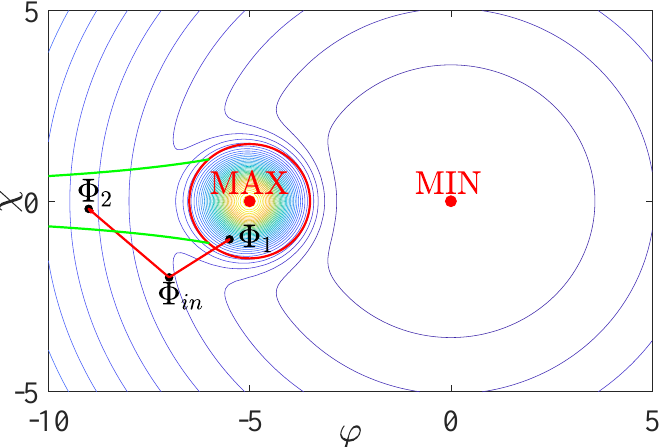
Figure 4. The contour plot of the potential (6) of scalar fields. The areas, surrounded by the red and green curves, show the regions which might be achieved by quantum fluctuations to form strings and domain walls, respectively. The areas differ by the factor κ ∼ 10 3 . If the fluctuations lead to the field values Φ 1 and Φ 2 , located outside the regions, the vacuum solution inevitably occurs. The initial possible field value, Φ in , and the subsequent values Φ 1 and Φ 2 are shown schematically. The labels “MIN” and “MAX” indicate the global minimum and the local maximum (peak) of the potential,